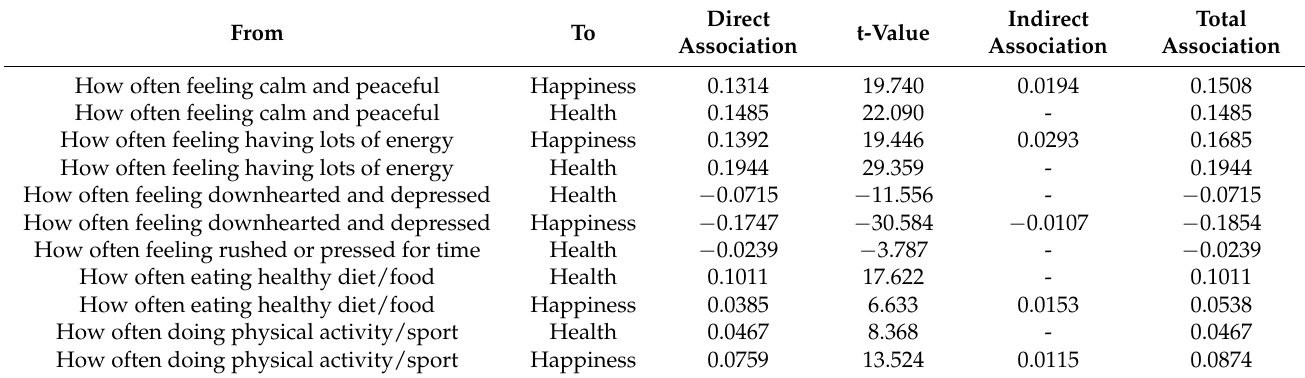
Table 5. Model fits and